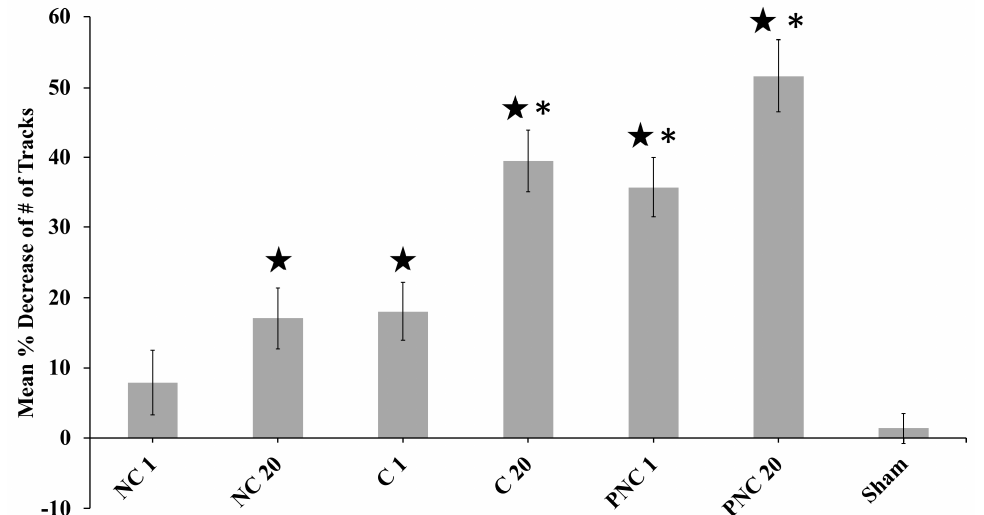
Figure 2. The mean percent decreases in the number of tracks exhibiting directed motion per cell, following nsPEF delivery, reveal that all exposures result in decreased tracks. Of the conditions tested, only the sham and the single nsPEF exposure in Ca 2+ -free solution (NC 1) do not have a significant decrease in the number of tracks (that contain appropriately sized particles detected in at least five consecutive frames). Error bars represent the cell-to-cell standard error of the mean (SEM), and star shapes ( (cid:70) ) denote statistical significance using the Rank-Sum (rs) test at alpha = 0.01 compared to pre-exposure. Asterisks (*) denote statistical significance using a Student’s two-tailed t -test (tt) with alpha = 0.01 compared to sham. Values plotted in the graph are: NC 1 (number of cells (n) = 6, Y = 7.95%, SEM = 4.54, rs-p = 0.240, tt p = 0.234); NC 20 (n = 5, Y = 17.0%, SEM = 4.37, rs p = 0.00866; tt p = 0.0185); C 1 (n = 3, Y = 18.1%, SEM = 4.14, rs p = 0.0238, tt p = 0.0378); C 20 (n = 9, Y = 39.5%, SEM = 4.38, rs p = 0.000400, tt p = 8.43 × 10 − 6 ); PNC 1 (n = 22, Y = 35.7%, SEM = 4.38, rs p = 0.000466, tt p = 1.38 × 10 − 7 ); PNC 20 (n = 7, Y = 51.6%, SEM = 5.17, rs p = 0.00117, tt p = 1.93 × 10 − 5 ); and sham (n = 6, Y = 1.39%, SEM = 2.18, rs p = 1.00, tt p = 1.00).